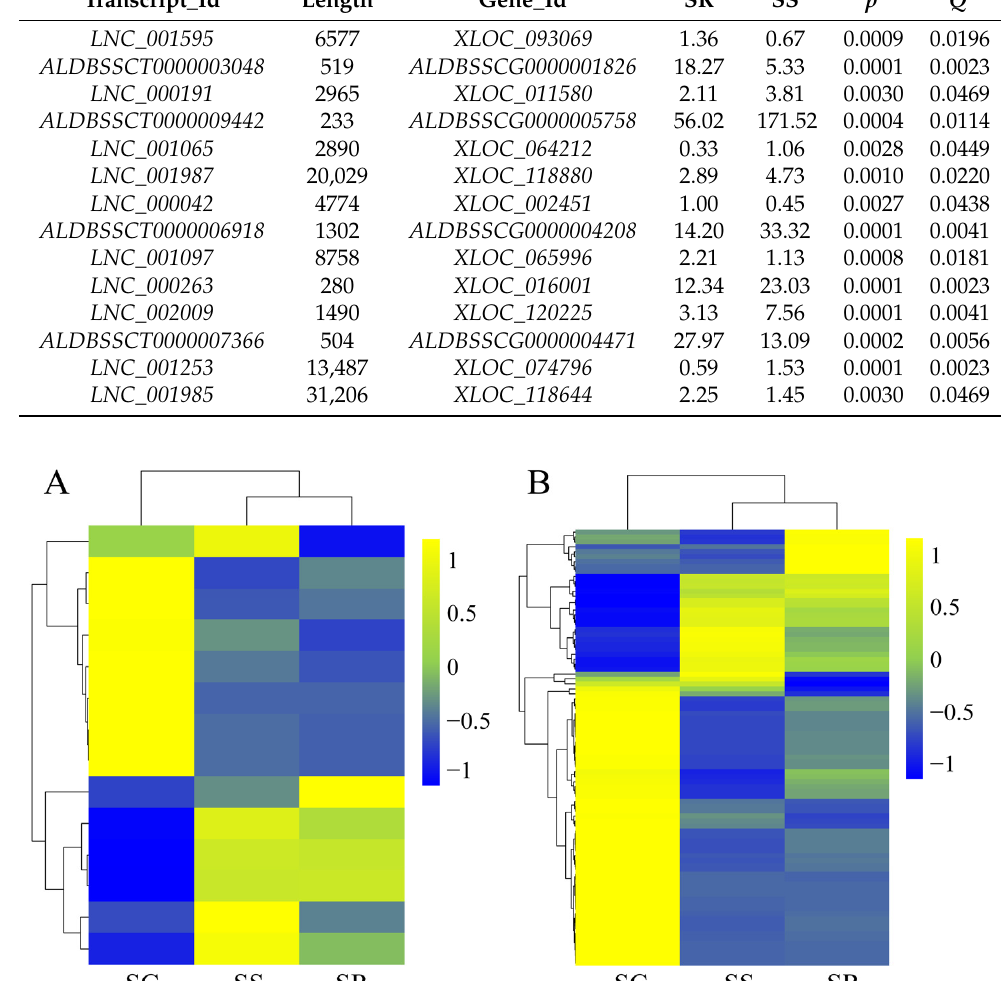
Figure 3. Hierarchical heat map showing the expression values for lncRNAs ( A ) and mRNAs ( B ).